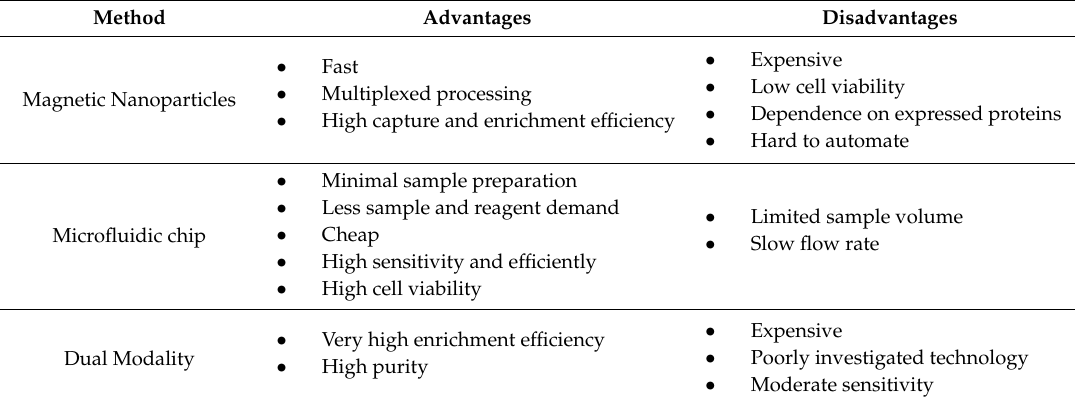
Table 2. Major advantages and disadvantages of CTC labeled detection